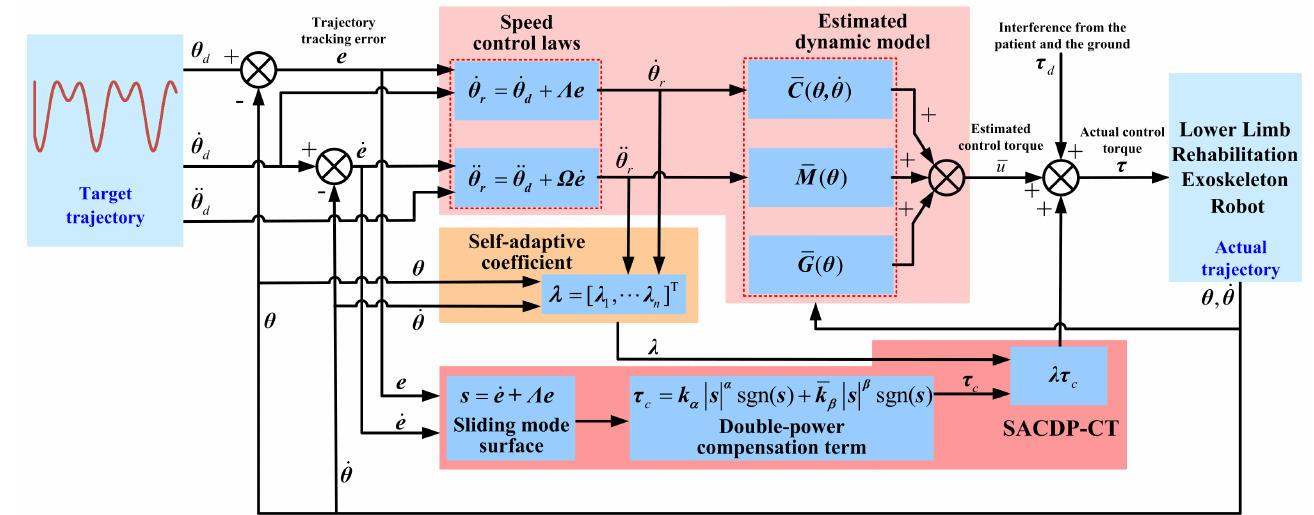
Figure 3. The control block